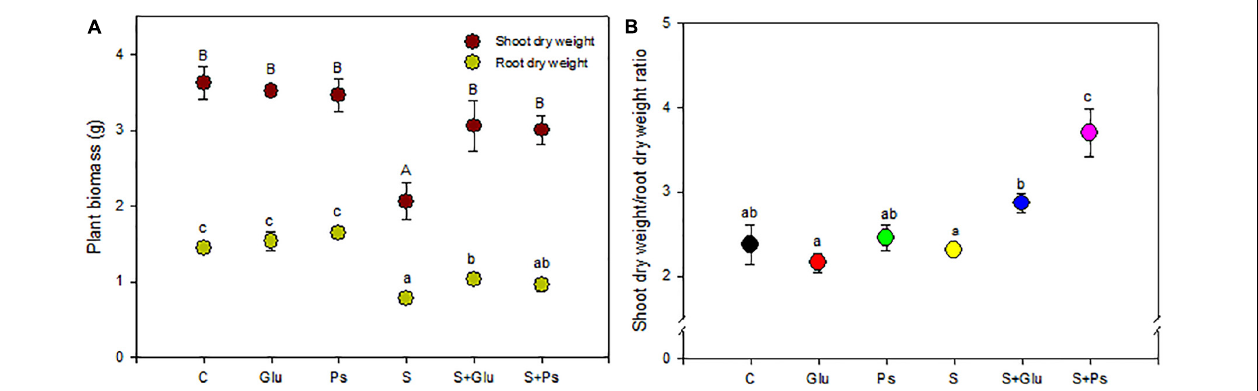
FIGURE 1 | Effect of bacterial inoculation on shoot and root dry weight (A) and shoot dry weight/root dry weight ratio (B) of S. fruticosa, in the absence (0 mM NaCl) and in the presence of NaCl (600 mM NaCl). Values are the means standard deviation of five replicates. Values sharing the different letters indicate significant differences between treatments at the 5% level